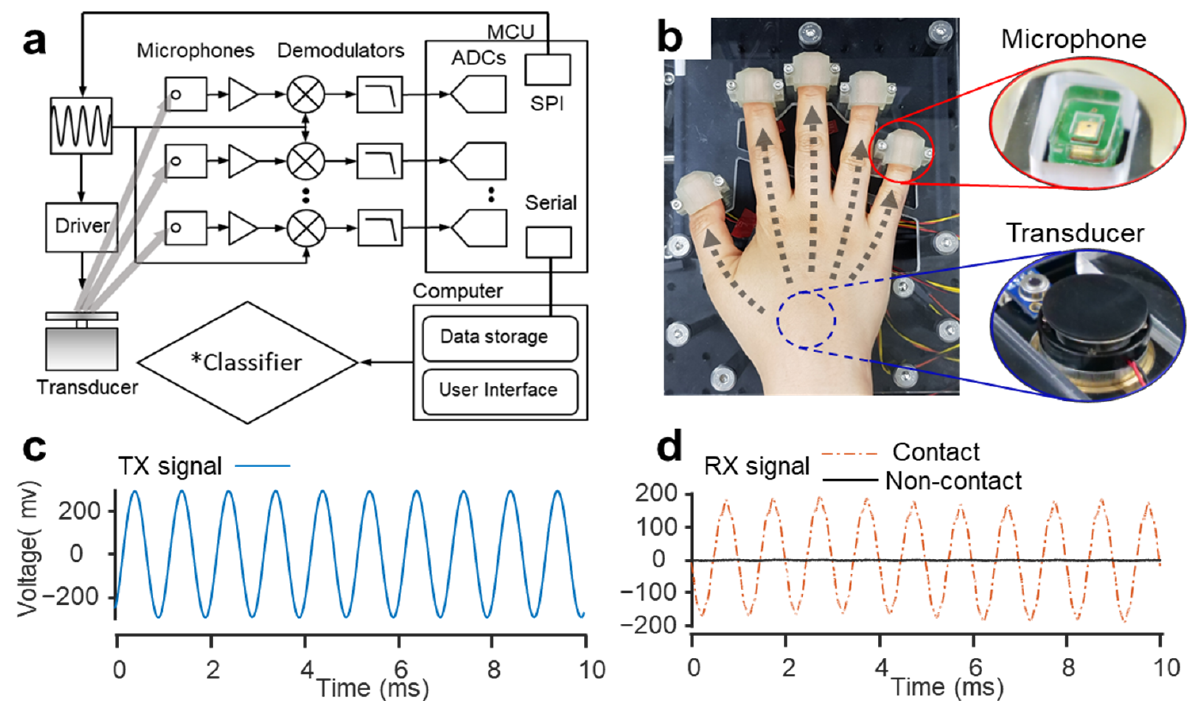
Figure 2. Design of the multichannel bioacoustic identity authentication system. ( a ) Schematic of the acoustic-spectra-based identity authentication system. The acquired data were transmitted to the user identification module. * Classifiers of choice in our proposed system were Random Forest (RF), kNN (k Nearest Neighbor), LDA (Linear Discriminant Analysis), SVM (Support Vector Machine), and CNN (Convolutional Neural Network). ( b ) Photo of the system simultaneously measuring fin- ger acoustic-transmitted spectra from five microphones by placing the hand of the subject on the platform. ( c ) The shape of the acoustic impedance spectrum applied to a finger through a bone con- duction transducer. ( d ) The difference in the signal received from the microphone depending on whether the transducer is in contact with the hand.